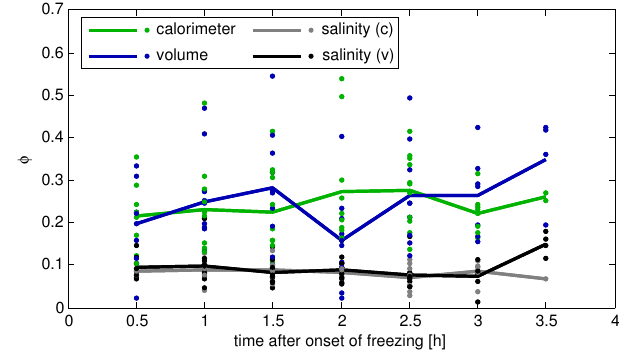
Fig. 3. Development of water temperature and salinity in the tank in one of the experiment with current and wind (air temperature at − 15 ◦ C). Temperatures and salinities are vertical averages over the four CTDs measuring at different depths in the tank (see Table 1). Table 2. Resulting error of the calculated solid fraction due to mea- surement inaccuracy for the three methods. salinity volume calorimeter